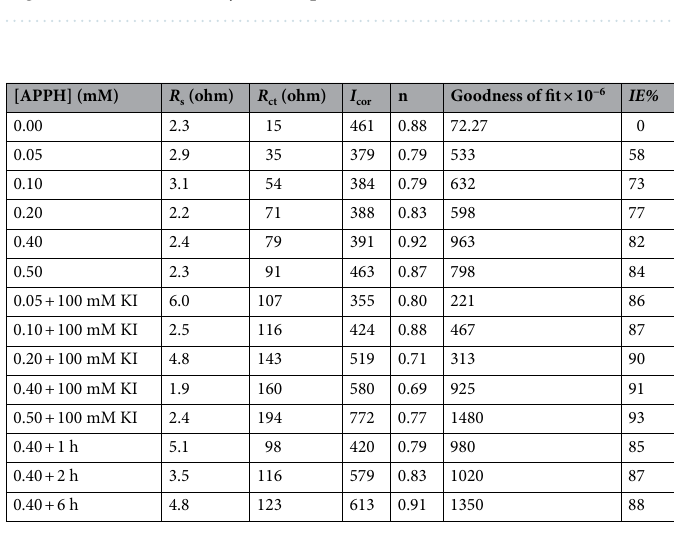
Figure 2. An inhibited system’s equivalent electrical circuit (CPE) with an inhibited system.